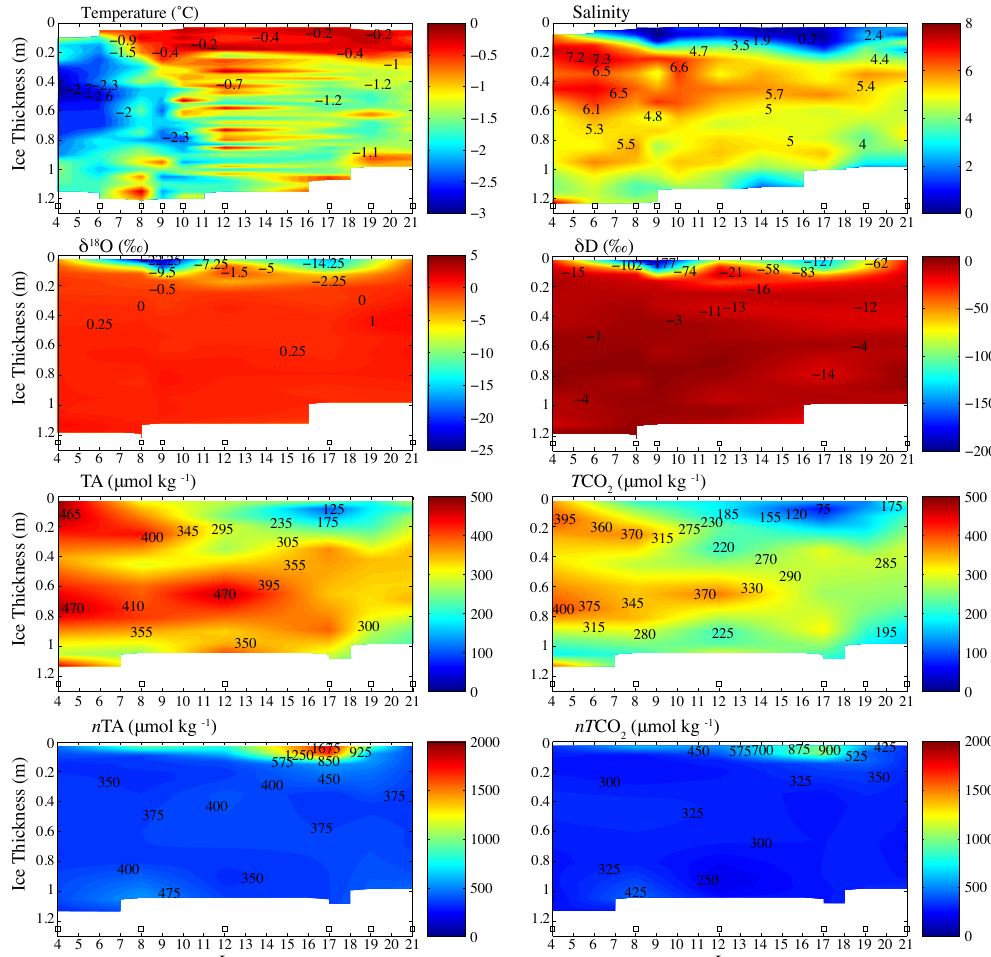
Figure 3. Temporal evolution of sea ice temperature ( ◦ C), salinity, isotopic composition of δ 18 O and δD (‰), TA ice and n TA ice (µmolkg − 1 ), T CO 2 and nT CO 2ice (µmolkg − 1 ). Open squares on the x axis mark the sampling